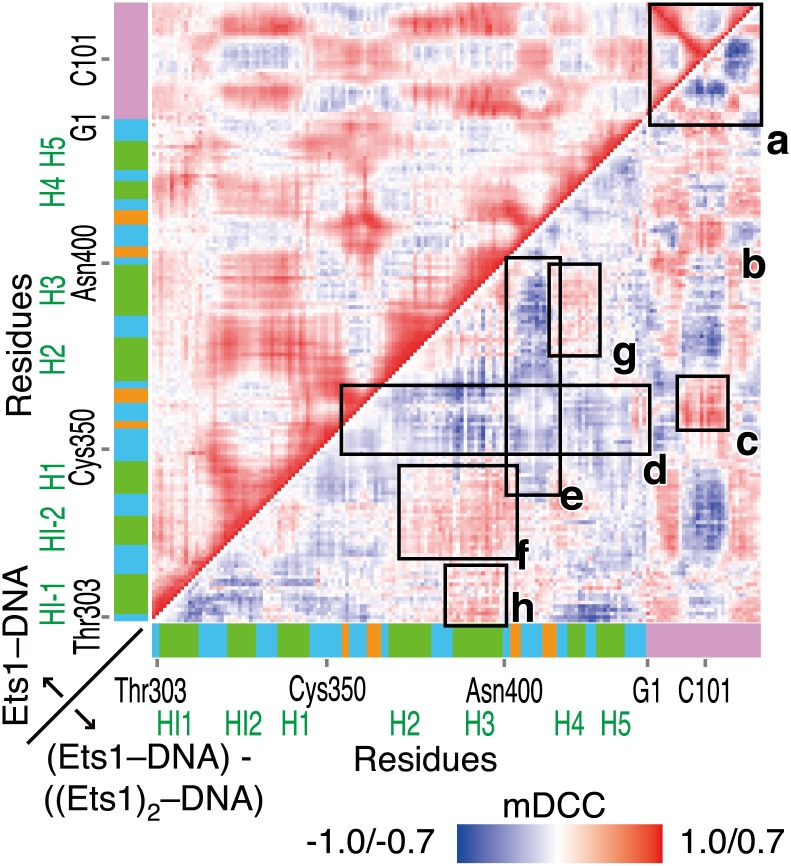
Comparisons of mDCC maps between the (Ets1)2–DNA and single Ets1–DNA models.The upper triangle shows mDCC values in the single Ets1–DNA model, with the color gradation from blue to red corresponding to mDCC values from −1.0 to 1.0. The lower triangle shows differences of the mDCC values in the single Ets1–DNA model from those in the (Ets1)2–DNA model with the color gradation corresponding from−0.7 to 0.7. For the lower triangle, negative values (blue) indicate correlations that decreased by the removal of the partner Ets1 molecule.